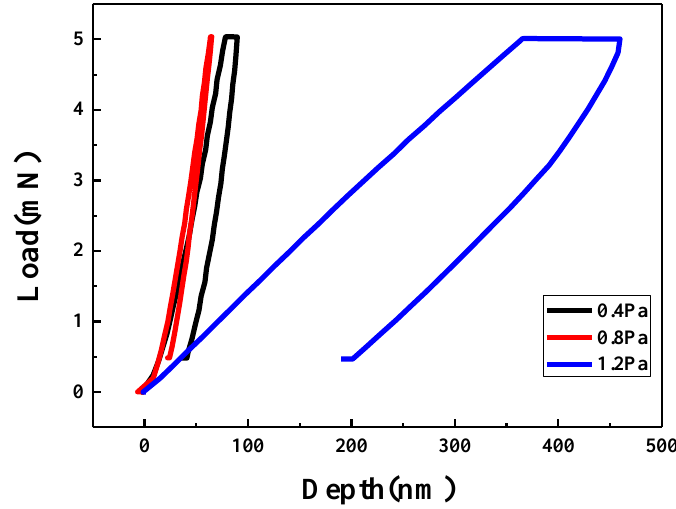
Figure 5. The typical load–displacement curves of Ta-Hf-C coatings under different working pressures.